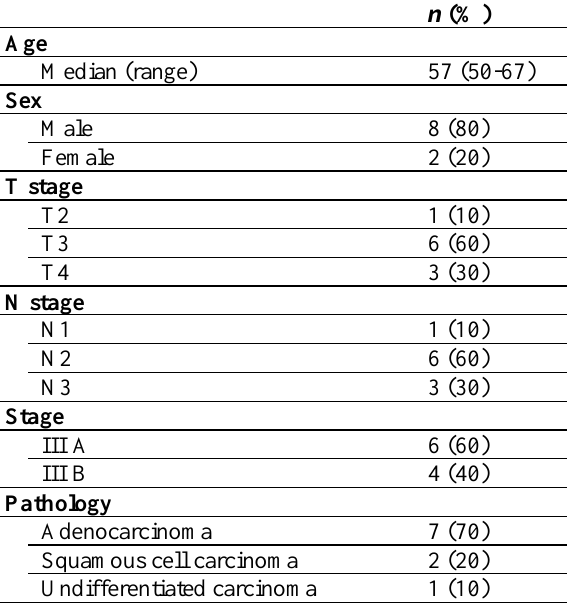
Table 1. Patients’